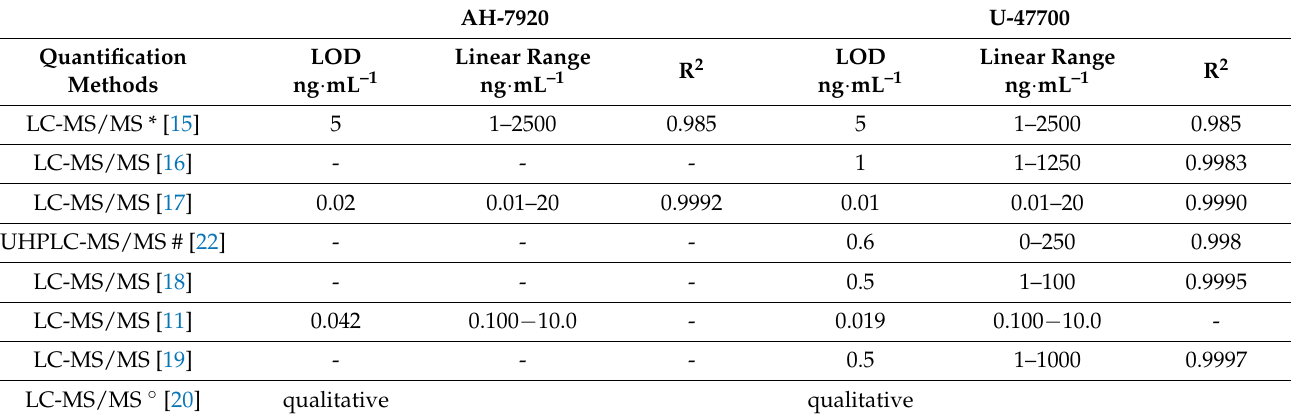
Table 1. Alternative methods for the determination of aroyl amides opioids, with their corresponding figures of merit. AH-7920